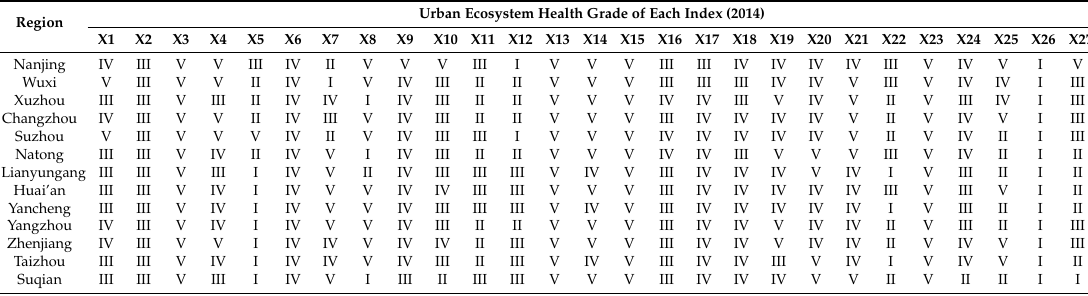
Table 4. UEH grade of each indicator of 13 cities in Jiangsu